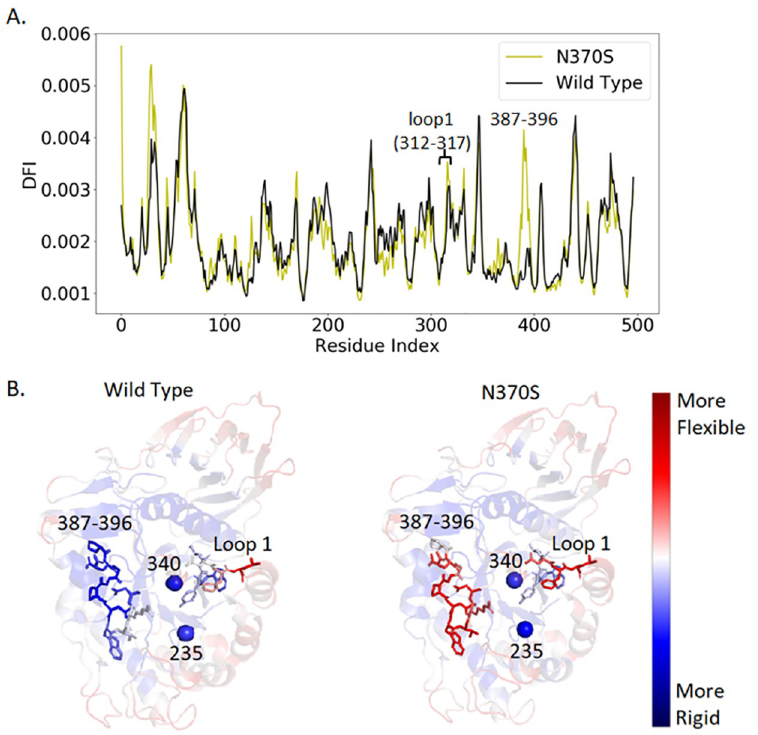
Fig 2. A comparison of DFI profiles of wild-type GCase and N370S mutant protein. ( a ) The %DFI profile of the mutant protein ( N370S , yellow) is contrasted with that of the wild-type (black). Dissimilarities in the two profiles demonstrate how a single point mutation ( N370S ) can induce changes in the flexibility profile of a different region of the protein. ( b ) Ribbon diagrams showing DFI as a color-coded spectrum from red-white-blue; red and blue indicate the highest and lowest flexibility, respectively. The regions with the most significant changes in dynamic flexibility are